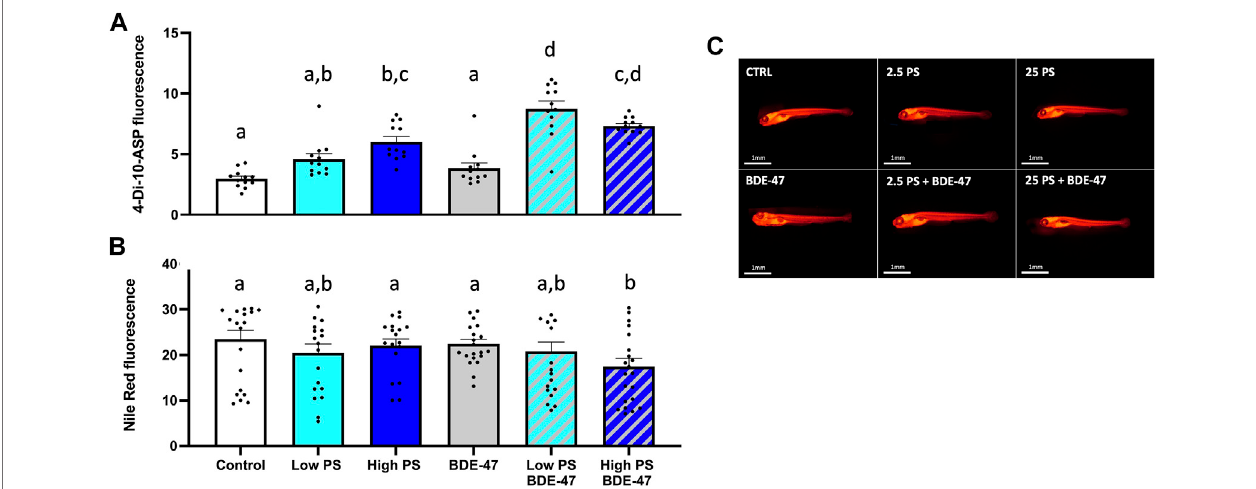
FIGURE 4 | Feed-intake (A) and neutral lipid deposition (B) of 7 dpf zebra fi sh larvae exposed to vehicle control, 2.5 ppm PS, 25 ppm PS, 10 ppt BDE-47 or their combinations. Individual measurements and average data +S.E.M. from n = 3 replicate assays with a combined n = 12 (A) and n = 18 – 22 (B) per treatment group are presented. Representative images of Nile Red based neutral lipid staining are shown (C) . Data were analyzed using a one-way ANOVA with a signi fi cance cut-off of p < 0.05. Different letters indicate signi fi cant differences between groups as analyzed by Tukey ’ s post-hoc test.